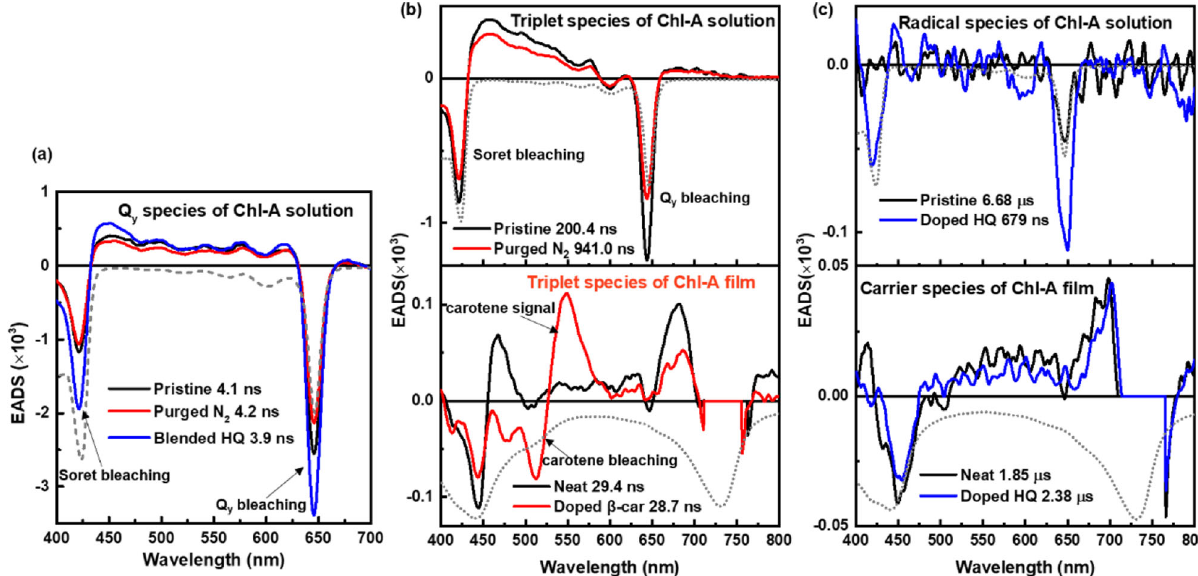
Fig. 3 The different species of EADS comparison of the Chl-A solution and fi lm. a Singlet species of the pristine Chl-A solution and the ones purged with N 2 gas and blended with HQ. b EADS of the triplet species of the Chl-A solution (the pristine Chl-A and the one purged with N 2 gas) and Chl-A fi lm (the neat and β -carotene-blended ones). c EADS of radical species of the Chl-A solution (the pristine Chl-A and the one blended with HQ) and carrier species of the Chl-A fi lm (the neat and HQ-blended ones). (The gray broken-dotted line of each fi gure is the inverted steady-state absorption spectrum of those represented by colored